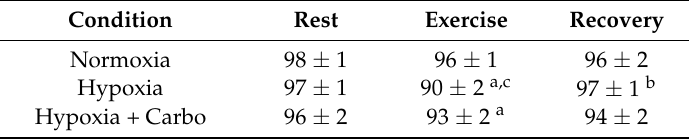
Table 1. O 2 saturation percent (SaO 2 %) at rest, after exercise and after recovery in normoxia, hypoxia and hypoxia + carbo. Condition Rest Exercise